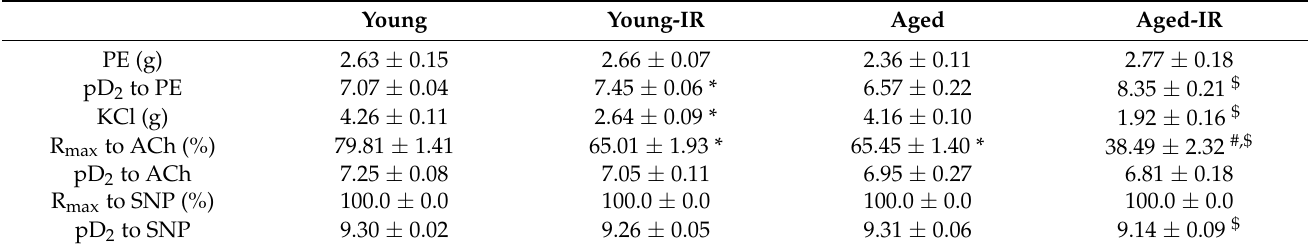
Table 1. Quantitative analysis of aortic vascular function after ischemia/reperfusion (IR) injury in young and aged